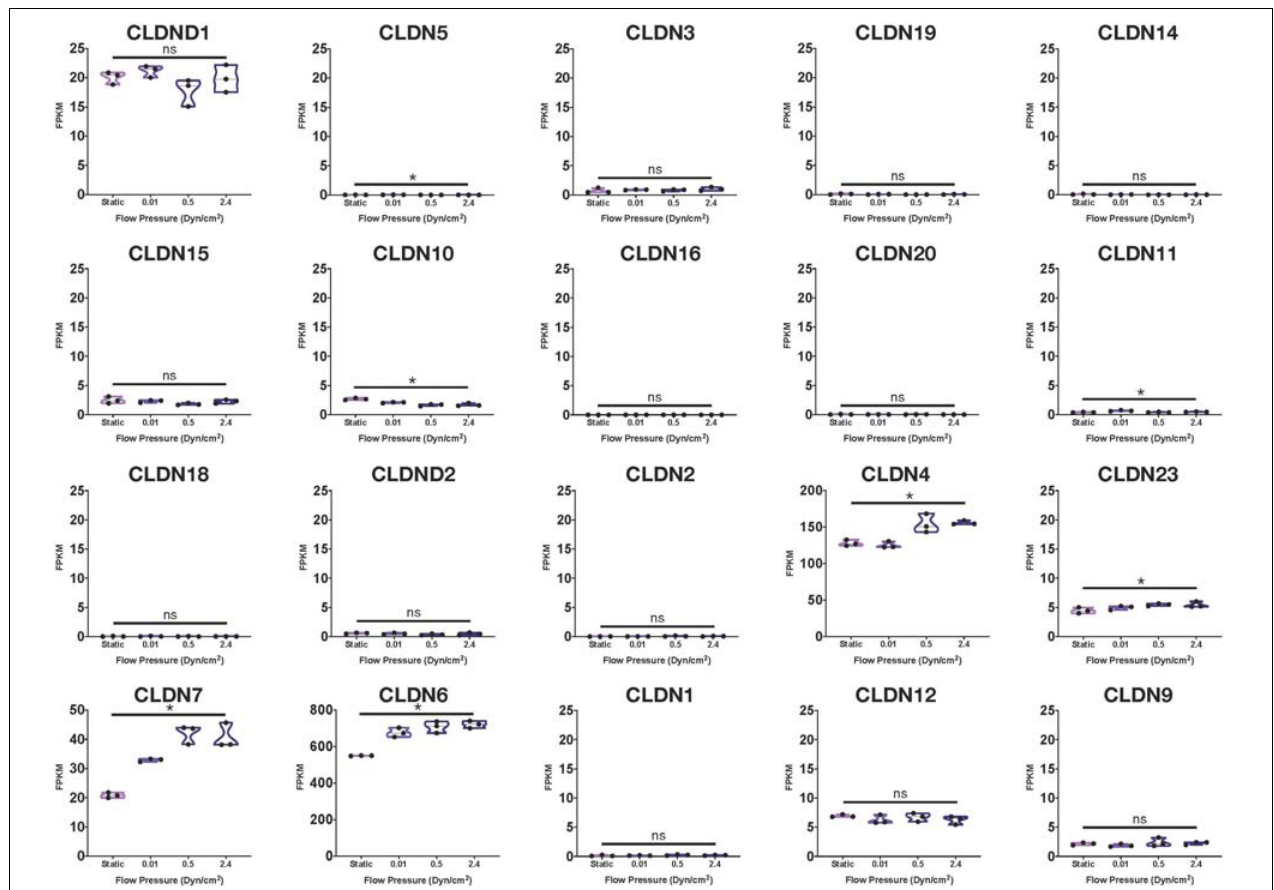
FIGURE 1 | Claudin family RNA expression in iBMECs under sheer stress. Violin plots of Claudin family gene expression in iBMEC organ-chip samples at various flow pressures adapted from data provided by Vatine et al. (2019) (significance indicates p -value < 0.05).